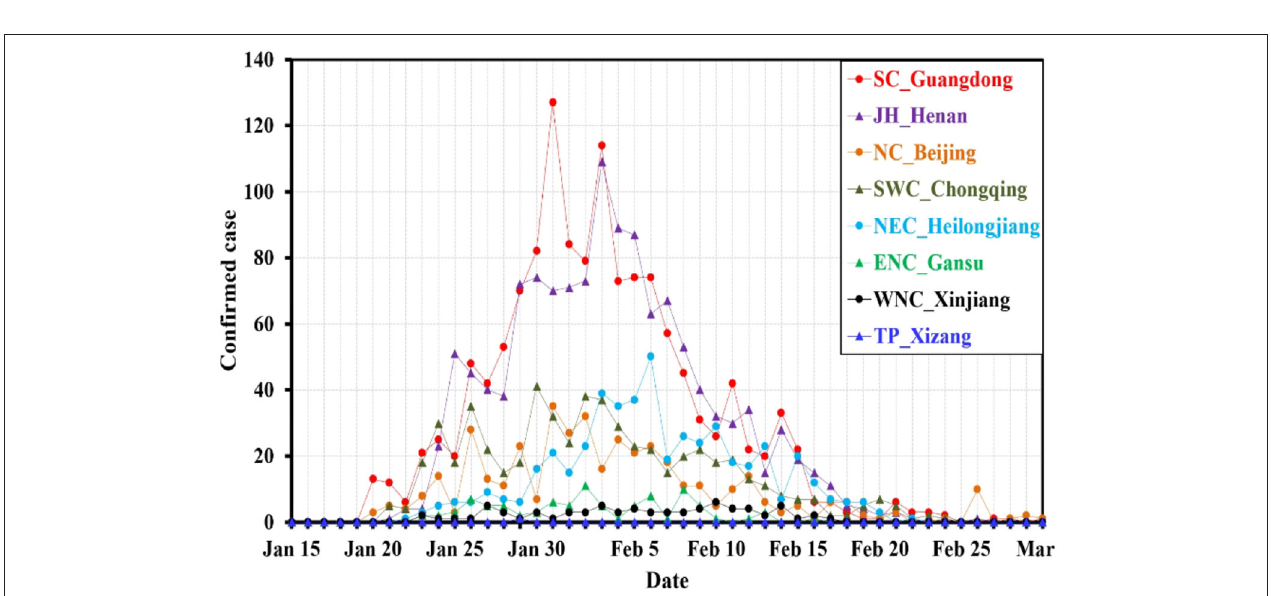
FIGURE 2 | The time series of confirmed cases in typical provinces of different climatic regions in China.